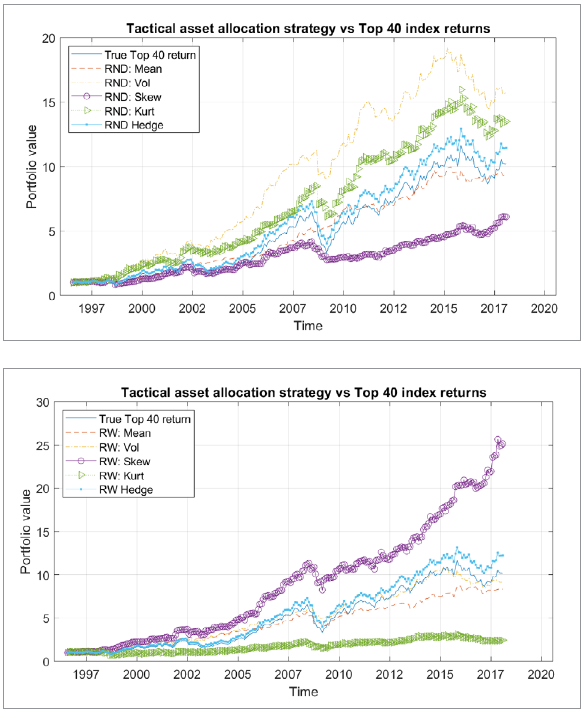
Figure 1: Tactical asset allocation with withdrawals returns using (a) the risk-neutral moments vs the Top 40 index returns and (b) the real-world moments vs the Top 40 index